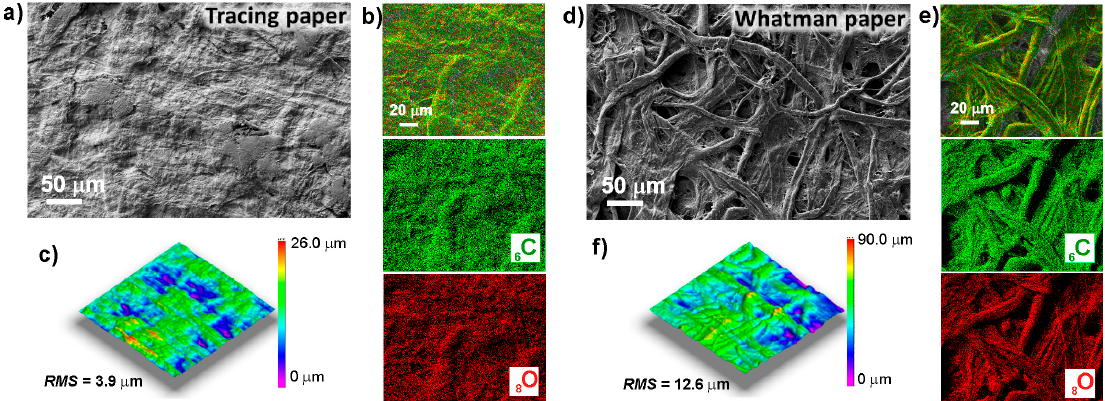
Figure 1. Scanning electron microscopy (SEM) images of ( a ) tracing paper and ( d ) Whatman paper substrates; ( b , e ) SEM images (artificial colored) together with the corresponding X-ray maps of C and O species of tracing and Whatman papers respectively; ( c , f ) Surface 3D profilometry of tracing and Whatman paper, respectively.